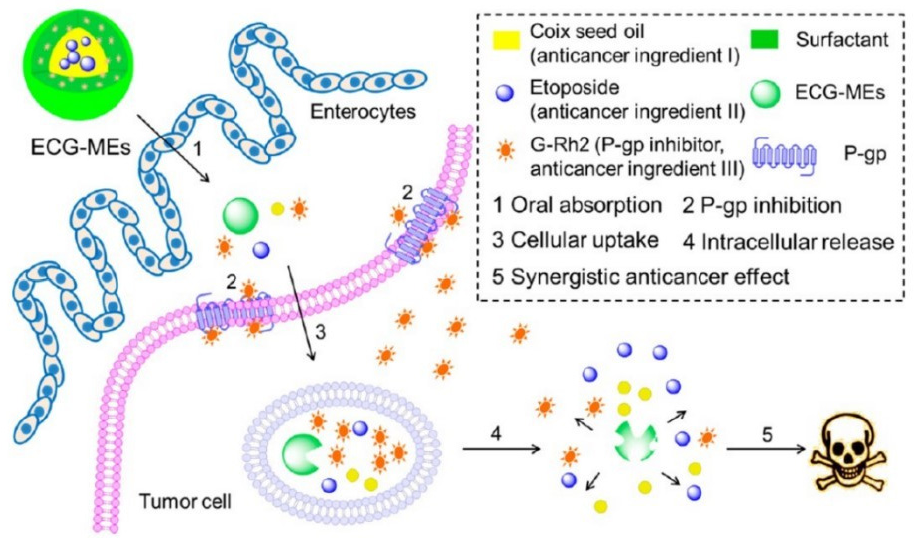
Figure 8. Schematic design of multicomponent microemulsions, ECG-MEs, for oral delivery of anticancer drug to overcome the MDR tumor. Reprinted with permission from [13]. Copyright© American Chemical Society.